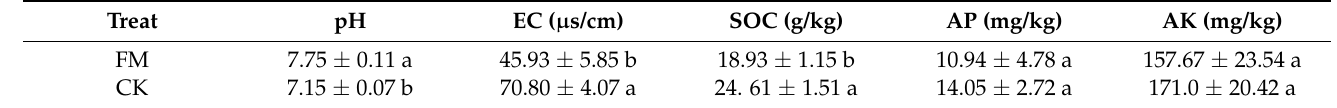
Table 1. Physical and chemical data of soil under different treatments. And “a” and “b” represent the significance of the difference between the data.